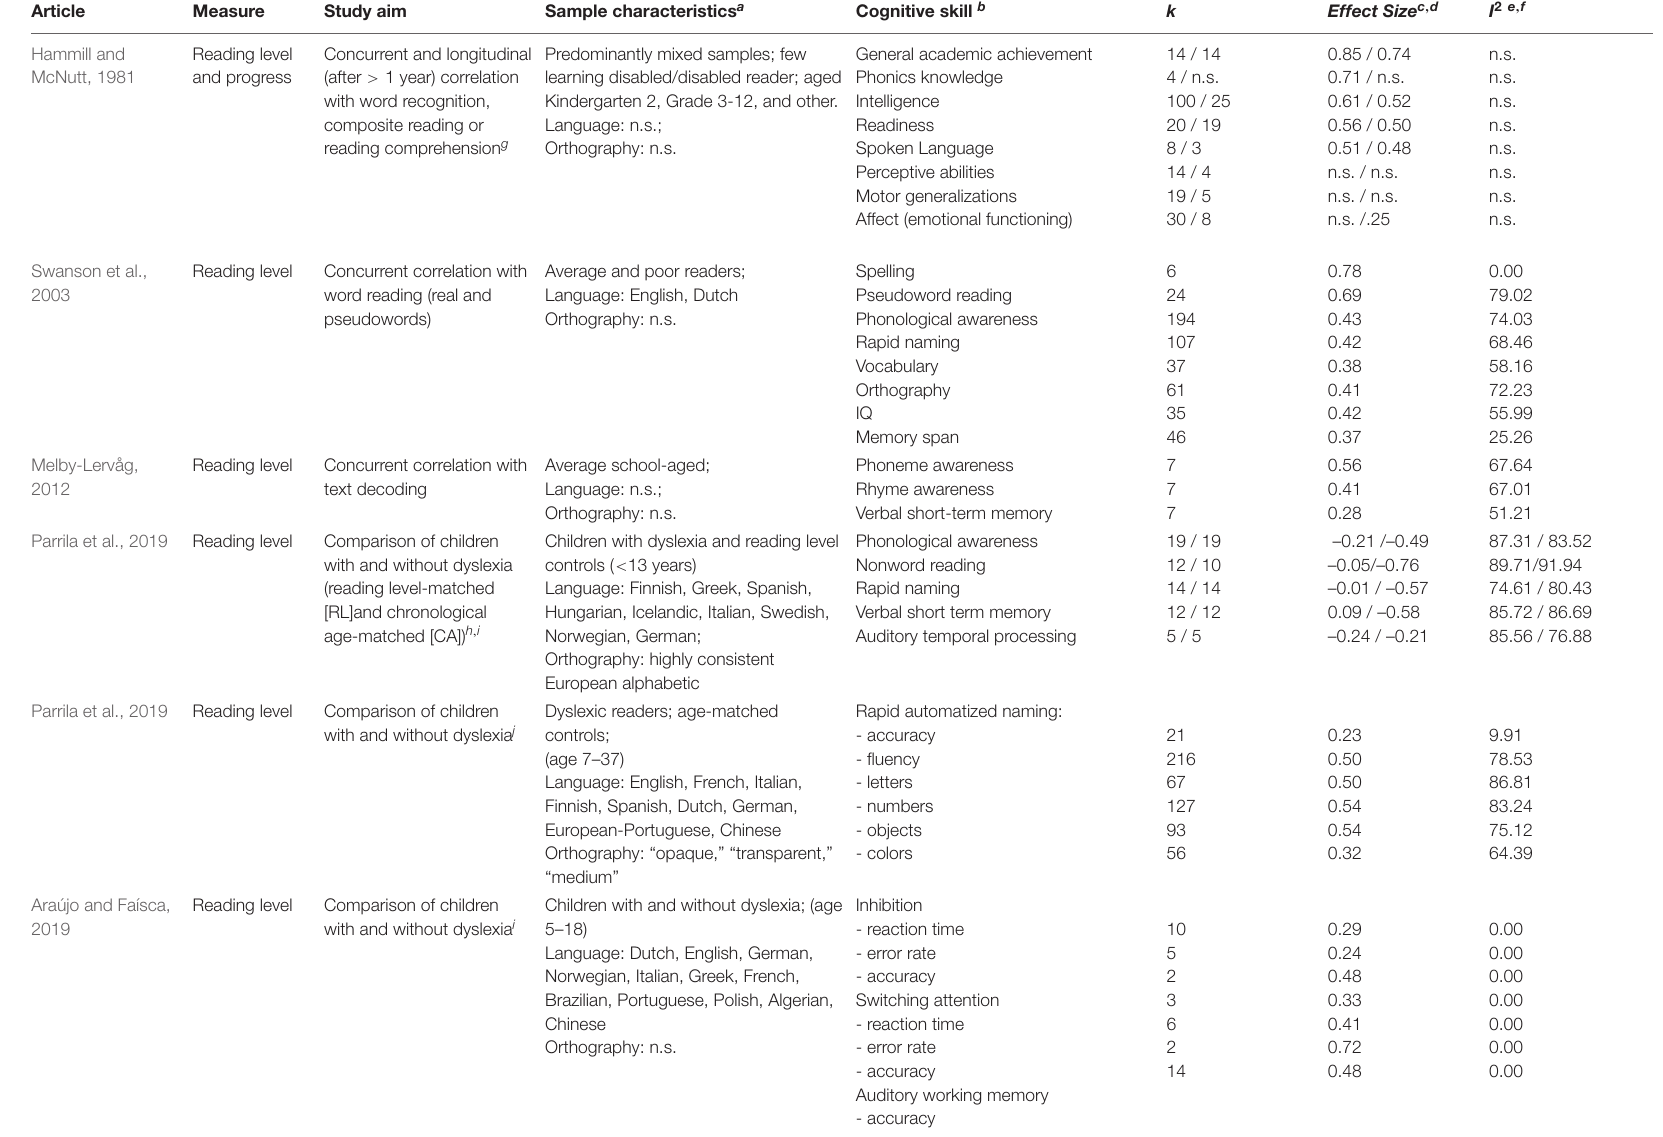
TABLE 1 | Results of meta-analyses on the relation between reading level and cognitive skills, and reading progress and cognitive